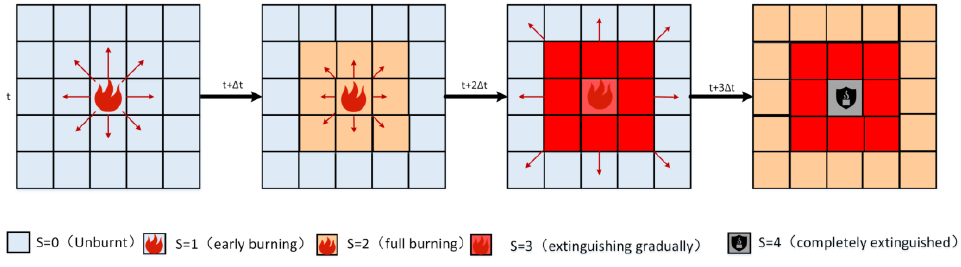
Figure 2. Cellular state change